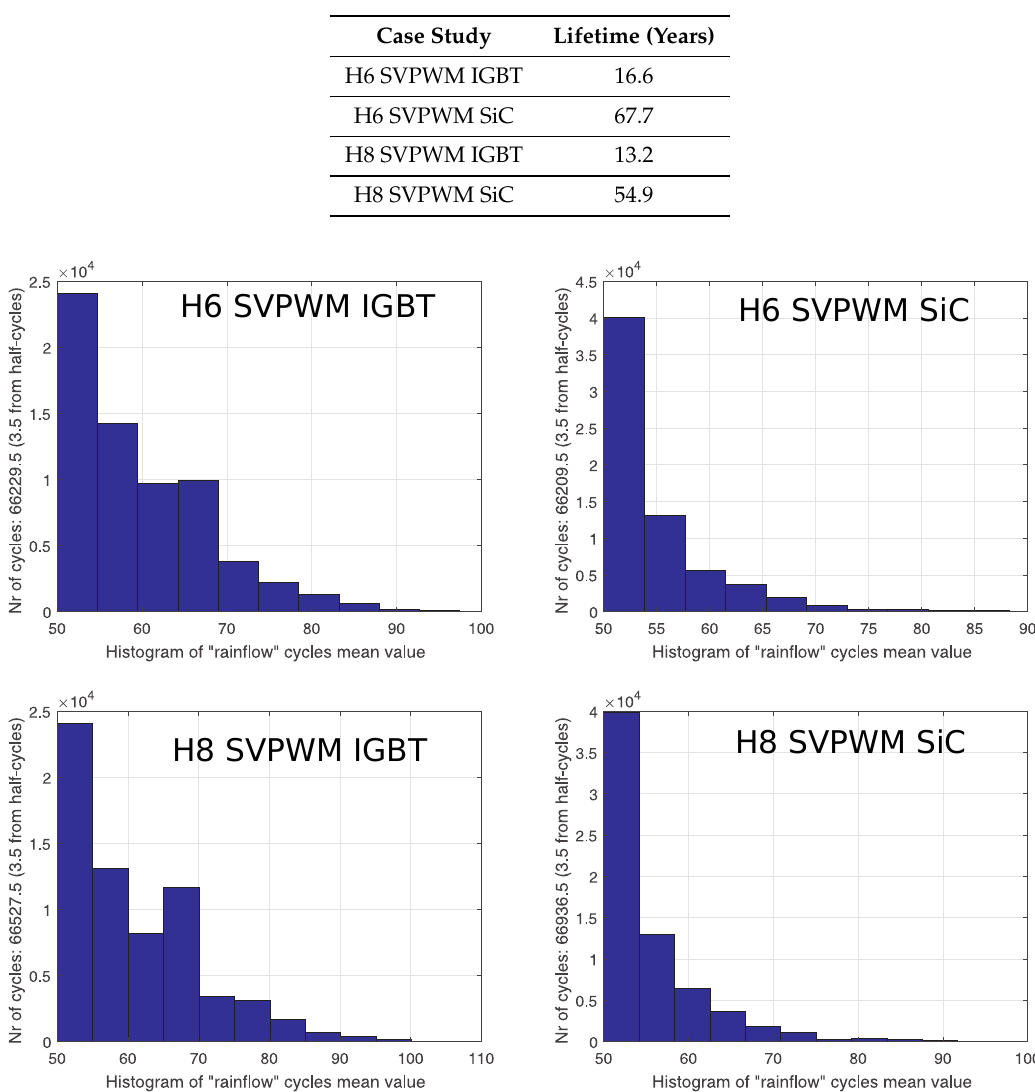
Figure 18. Accumulated damage at different average junction